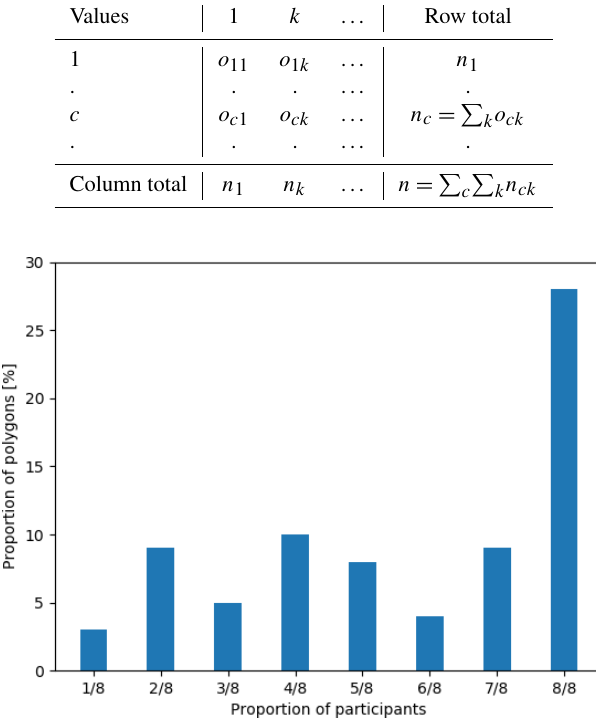
Figure 6. Validity of segmentation results as determined by ana- lysts. The vertical axis shows the proportion of all polygons used in this study. The categories on the horizontal axis indicate the pro- portion of all (eight) participants who agreed with the segmentation results. For example, eight out of eight participants reported that the segmentation results were valid 25% of the time.